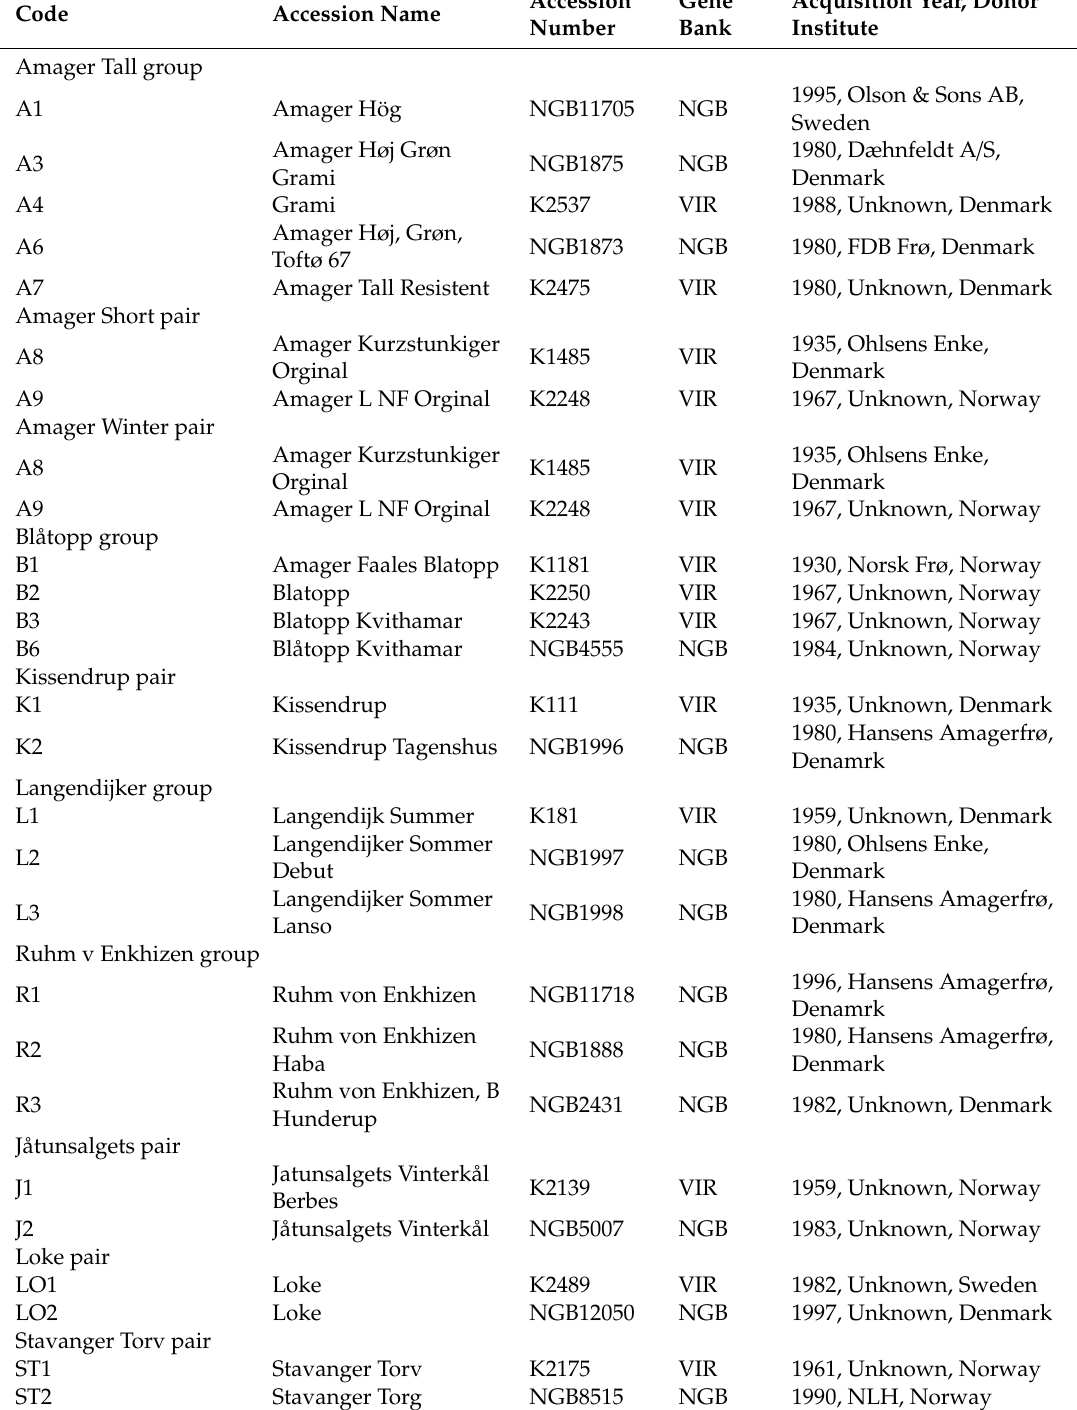
Table 1. Overview of the accessions included in the study, sorted into groups based on accession name. For each accession, a code is given. Information is provided on the accession number, genebank holding institute, acquisition year, and donor institute. Acquisition year indicates the year when the accession entered the genebank holding institute, and the donor institute is the organization from which the material was